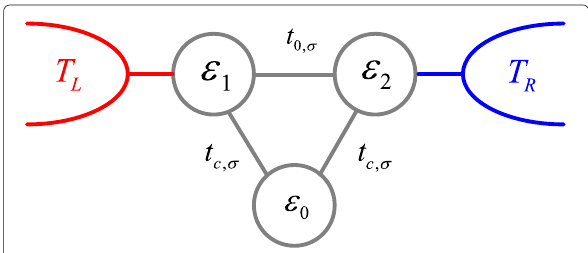
Fig. 1 Schematic plot of the triple quantum dots system. By applying a static magnetic field on the tunnel barriers between the dots, the interdot couplings become